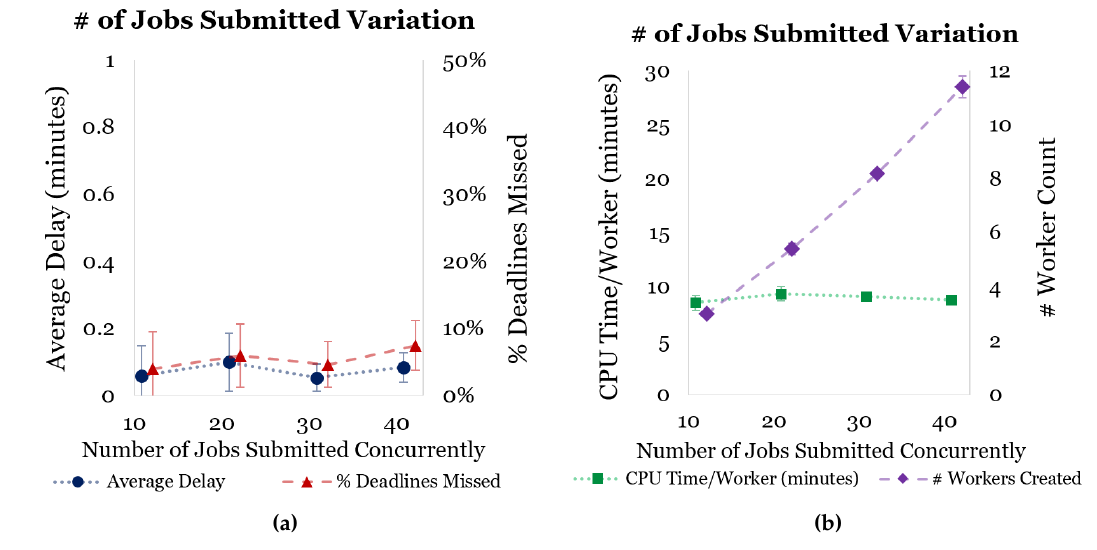
Figure 8. Variation in number of simultaneous jobs. ( a ) Deadline missed; ( b ) resource